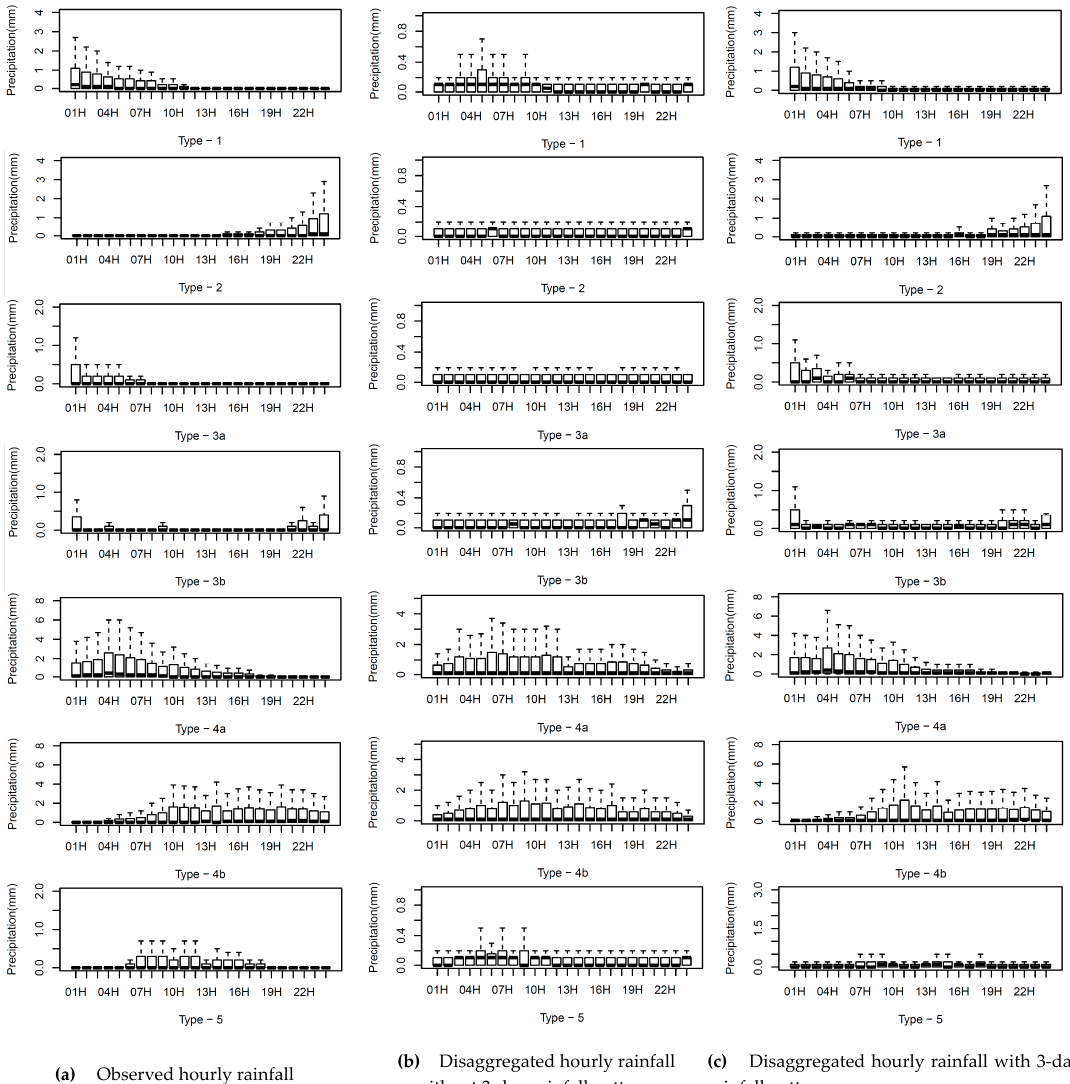
Figure 5. Hourly rainfall distribution in Seoul station ( a ) observed (original) data, ( b ) K-nearest neighbor resampling (KNNR) method without 3-day rainfall patterns, and ( c ) the proposed KNNR method with 3-day rainfall patterns.